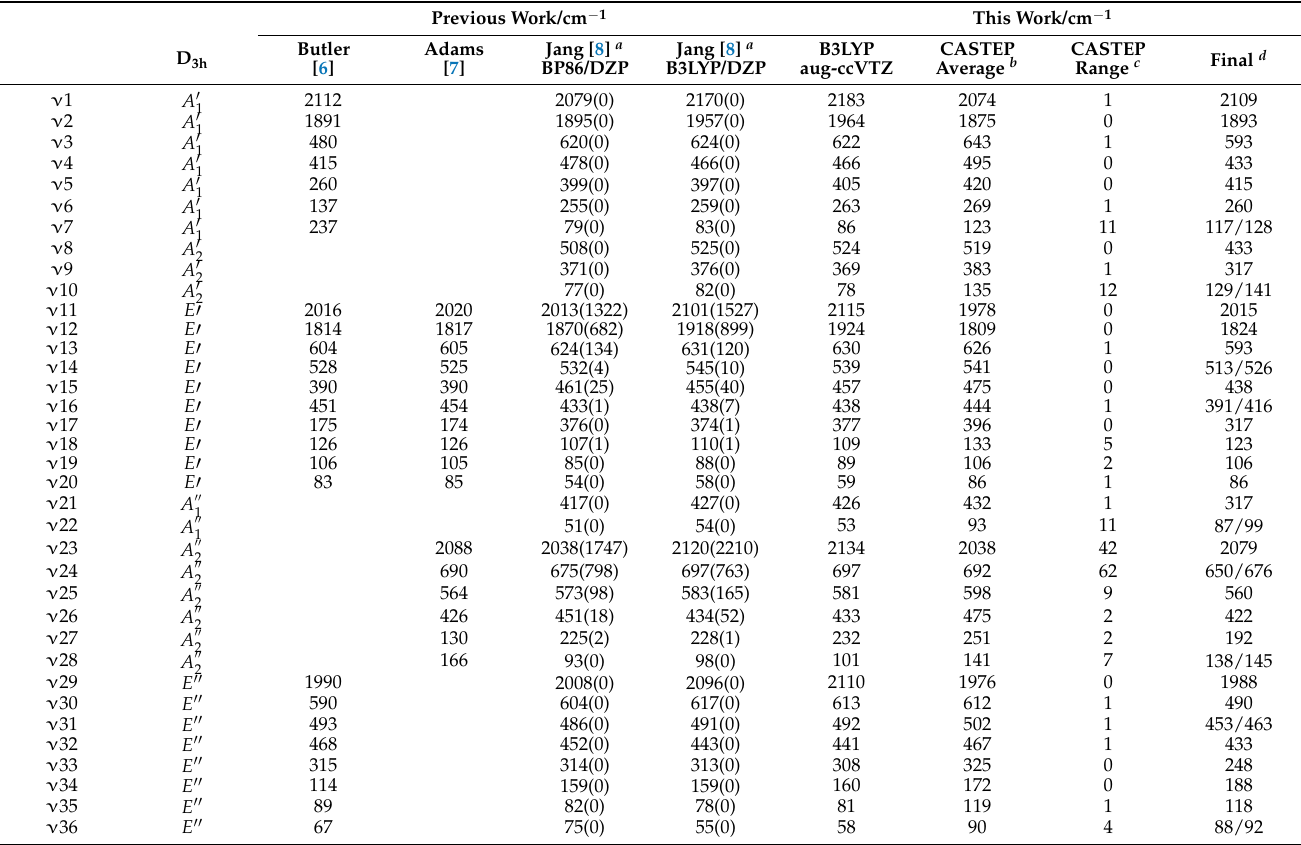
Table 1. Comparison of assignments (in D 3h symmetry) of Fe 2 (CO) 9